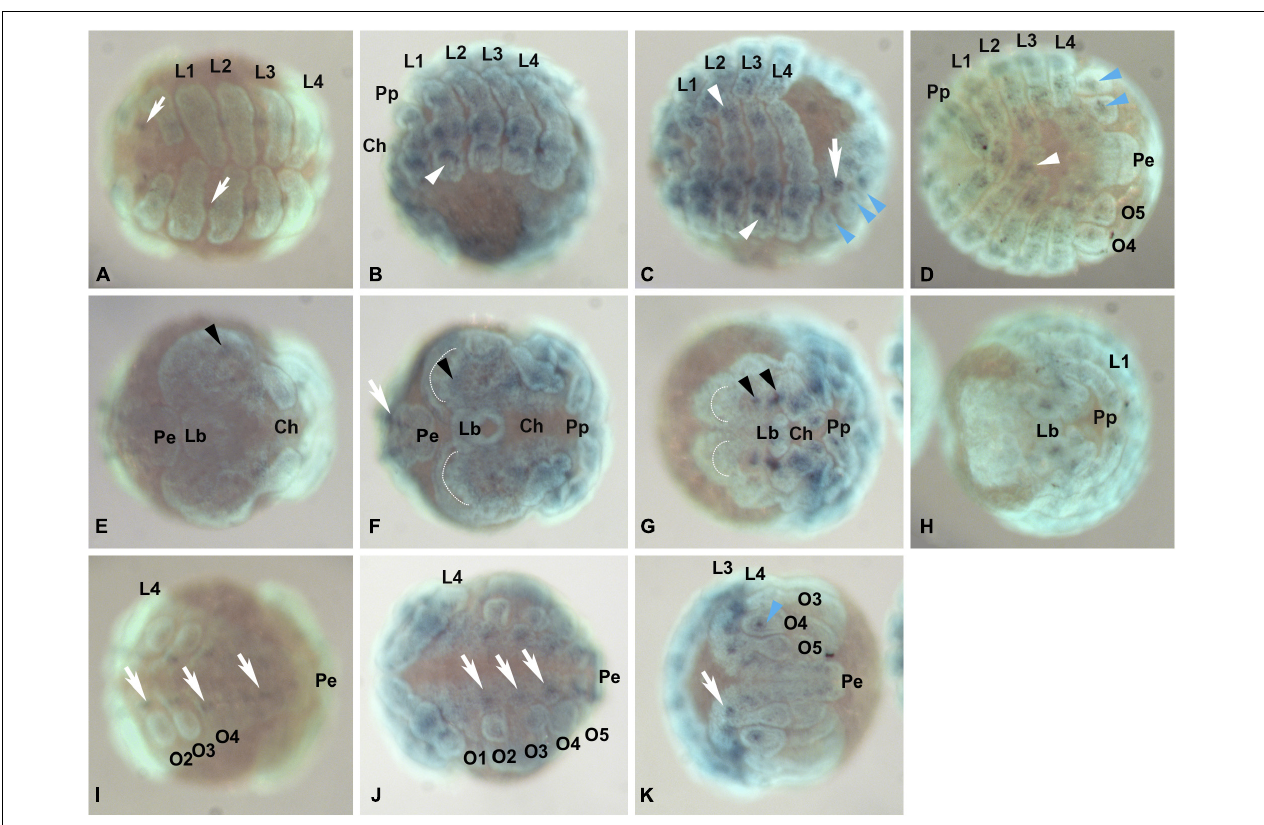
FIGURE 5 | Pt-Pax2.2 ( aug3.g12456 ) expression during embryogenesis. Leftmost panels (A,E,I) show embryos during early brain differentiation stages (Stage 10), the panels in the middle show embryos during inversion (Stage 11, B,F,J ) and between retraction and dorsal closure (Stage 12/13, C,G,K ), while the rightmost panels (D,H) show embryos during early ventral closure (Stage 14.1). (A–D) Embryos shown in ventral (or lateral ventral) aspect. Pt-Pax2.2 is expressed in the ventral neuroectoderm (white arrows), and later in the prosomal and opisthosomal appendages (white and blue arrowheads, respectively). (E–H) Pt-Pax2.2 expression domains in the head lobes (black arrowhead) shown in embryos in frontal view. (I–K) Opisthosomal view showing Pt-Pax2.2 expression in the opisthosomal ventral neuroectoderm (white arrows) and opisthosomal appendage, the developing spinneret on O4 (blue arrowhead). Anterior is to the left in all panels, all images show ventral aspects, except (E–H) which are in frontal aspect and (B) shown in ventral-lateral view. Dotted half circles indicate the anterior furrow in the prechericeral head lobes. Lb, labrum; Pe, Posterior end; O1–O5, Opisthosomal segments 1–5; Prosomal appendages: Ch, chelicerae; Pp, pedipalps; L1-L4, 1st to 4th walking leg. Dark blue, NBT/BCIP staining showing specific Pt-Pax2.2 expression; cyan, nuclear Sytox staining.